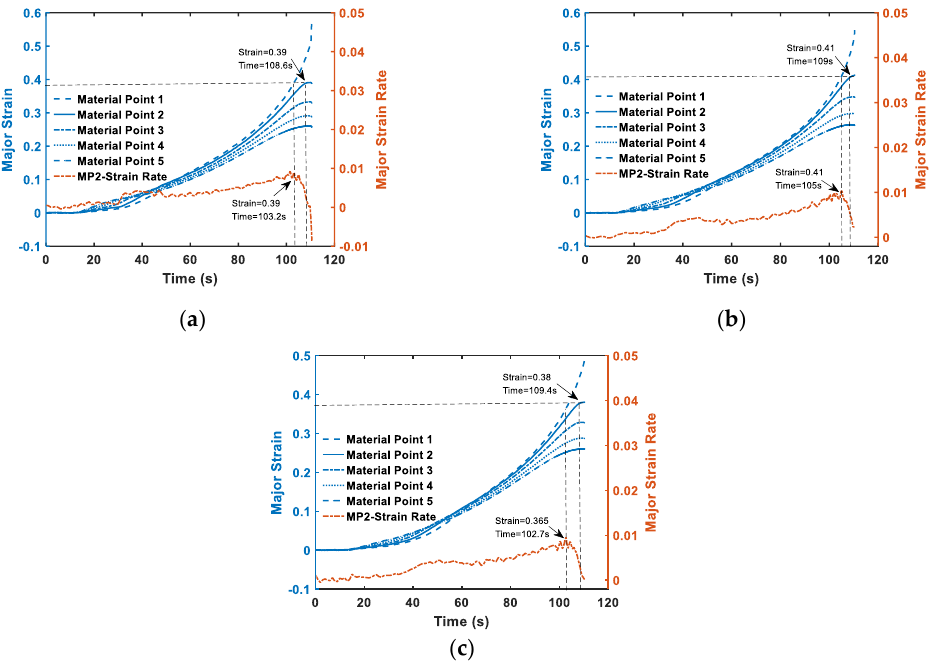
Figure 7. Major strain and strain rate evolution for the first test: ( a ) section a; ( b ) section b; ( c ) section